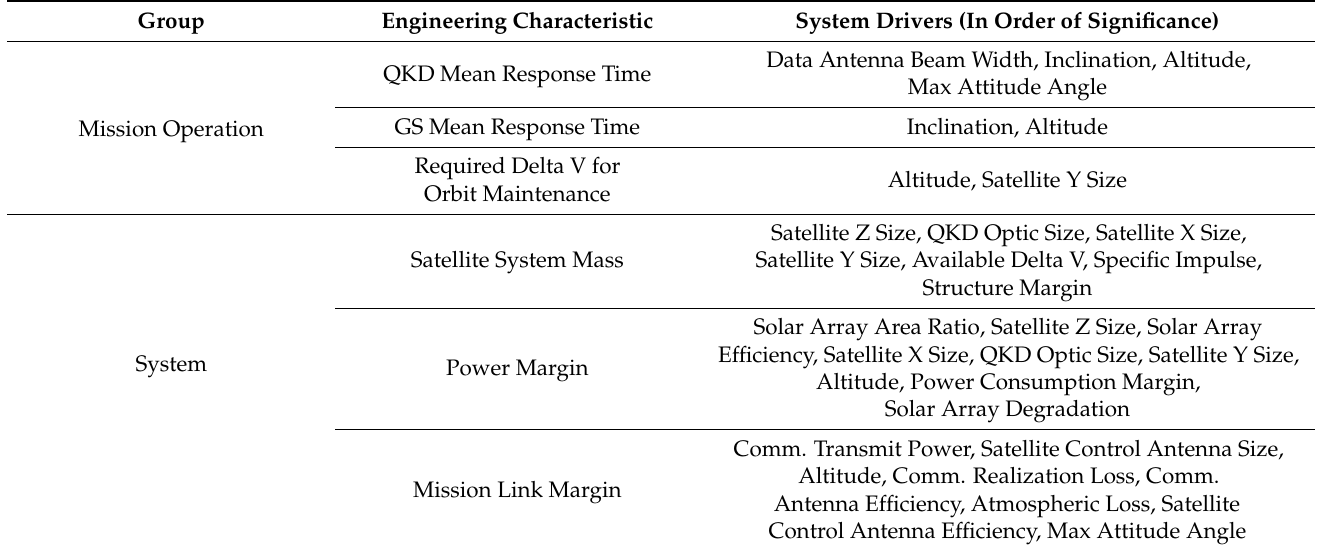
Figure 7. Pareto analysis result for Satellite System Mass. Table 8. System drivers for each engineering characteristic (in order of significance).